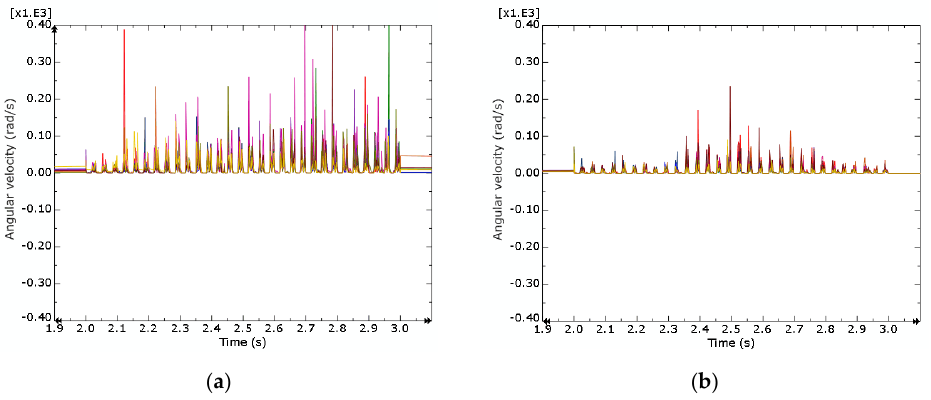
Figure 9. Combined angular velocity of different mixtures: ( a ) AC 11; ( b ) PA